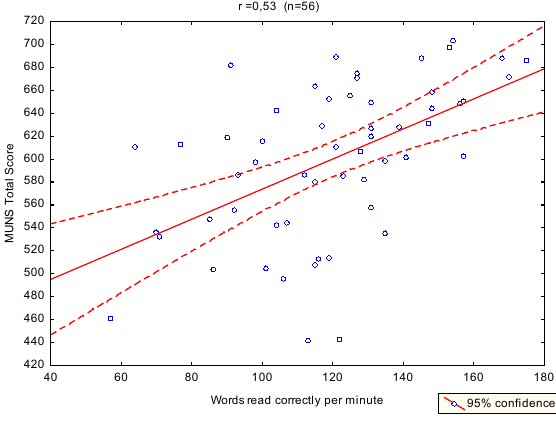
Figure 2. Correlation between MUNS total score and words read correctly per